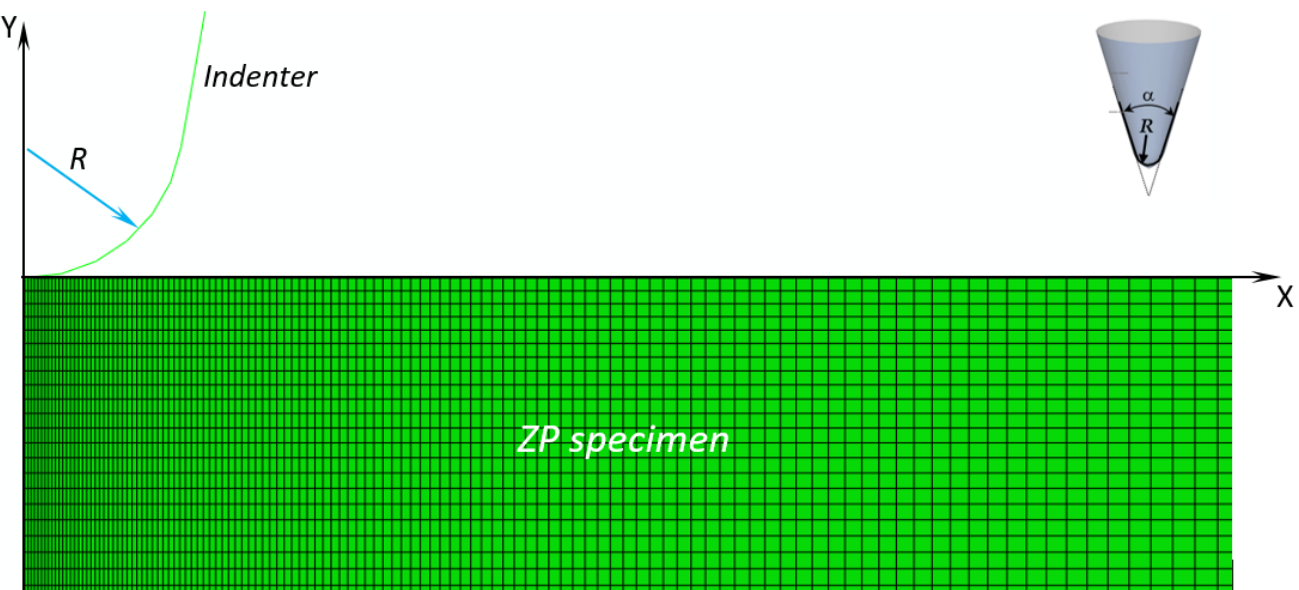
Figure 1. ABAQUS model simulating the nanoindentation process of the equine zona pellucida (ZP) specimens and 3D sketch of the blunt cone indenter geometry.